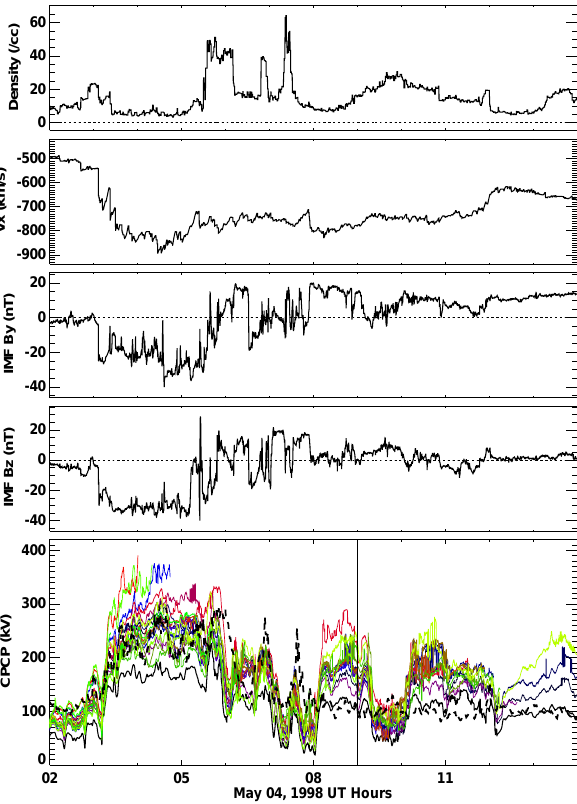
Fig. 11. The top figure shows the ionospheric cross polar cap poten- tial as a function of run-time, with the base-line 2nd order scheme (dashed) and a simulation with similarly high resolution on the day- side (solid). The smallest grid cell size (in R E ) is indicated above the solid line. The bottom figure shows the ratio between the cross polar cap potentials derived from the simulations using a refined dayside grid and a fixed dayside grid.